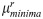
Cruciality bar-codes.Each row shows μminimar, μcapsidr and their ratio in two BMV 5-fold interface assembly systems (VP monomer-monomer and VP monomer-dimer shown at bottom right) where the interaction r—listed as the row label—is removed. The row labeled ‘None’ is the “wild-type” assembly system where no interaction has been removed, whose νminima and νcapsid values have been normalized. The rows are sorted according to the largest value of μcapsid. See the section on output of cruciality prediction.